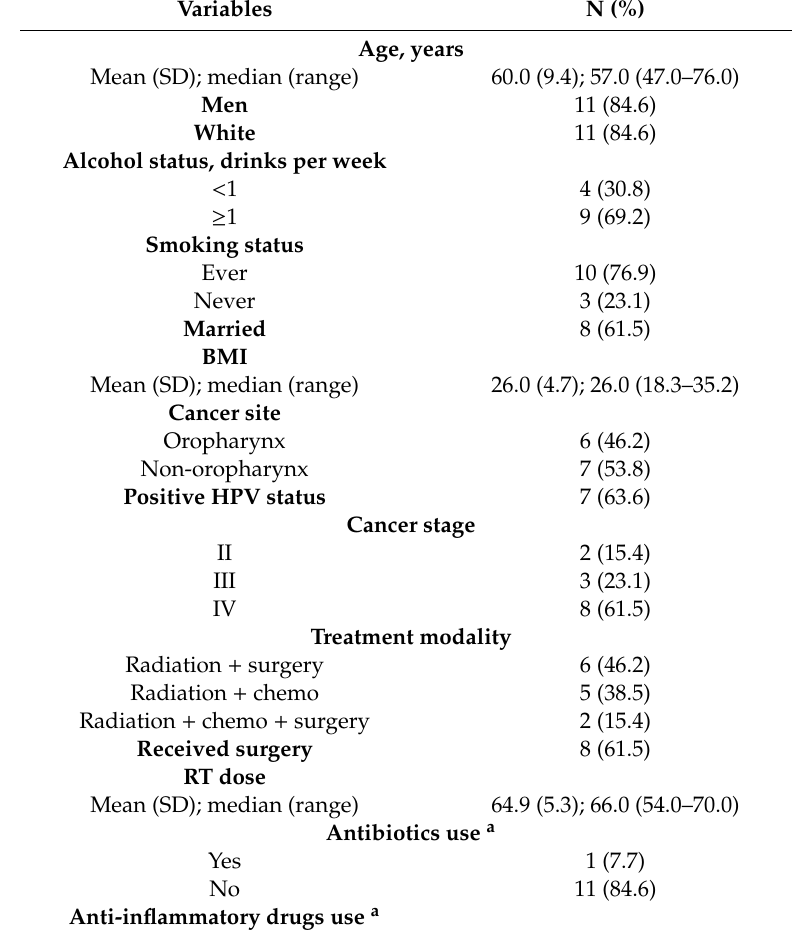
Table 1. Demographic and clinical characteristics ( n =